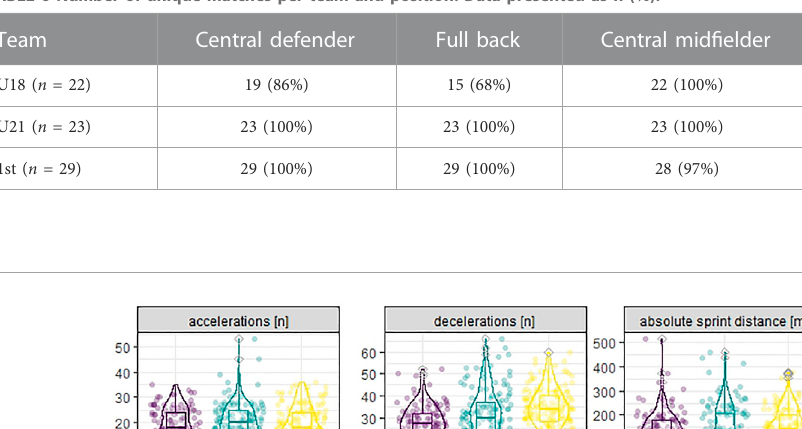
TABLE 6 Number of unique matches per team and position. Data presented as n (%).